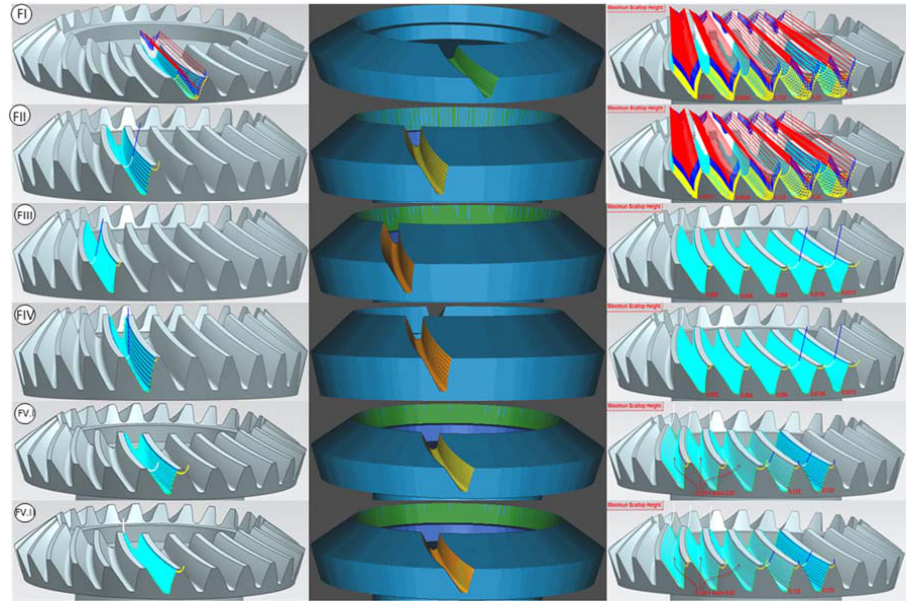
Figure 11. Finishing operations. Machined finishing operations explained in Table 5 are shown in F ‐ I–F ‐ V.2. I–F ‐ V.2.